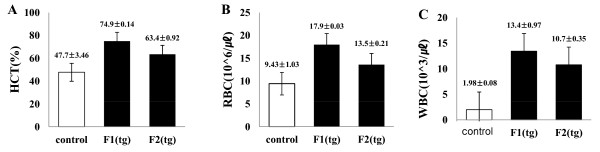
Blood cell counts of dHuEPO transgenic mice. Hematological parameters showed that tg mice had markedly increased RBC, WBC, and HCT values. All data are mean ± SD. A: HCT (%); B: RBC (× 106/μL); C: WBC (× 103/μL). HCT: hematocrit; RBC: red blood cell; WBC: white blood cell; F1 (tg): F1 female mice produced from founder #11; F2 (tg): F2 female mice produced from F1 founder male.